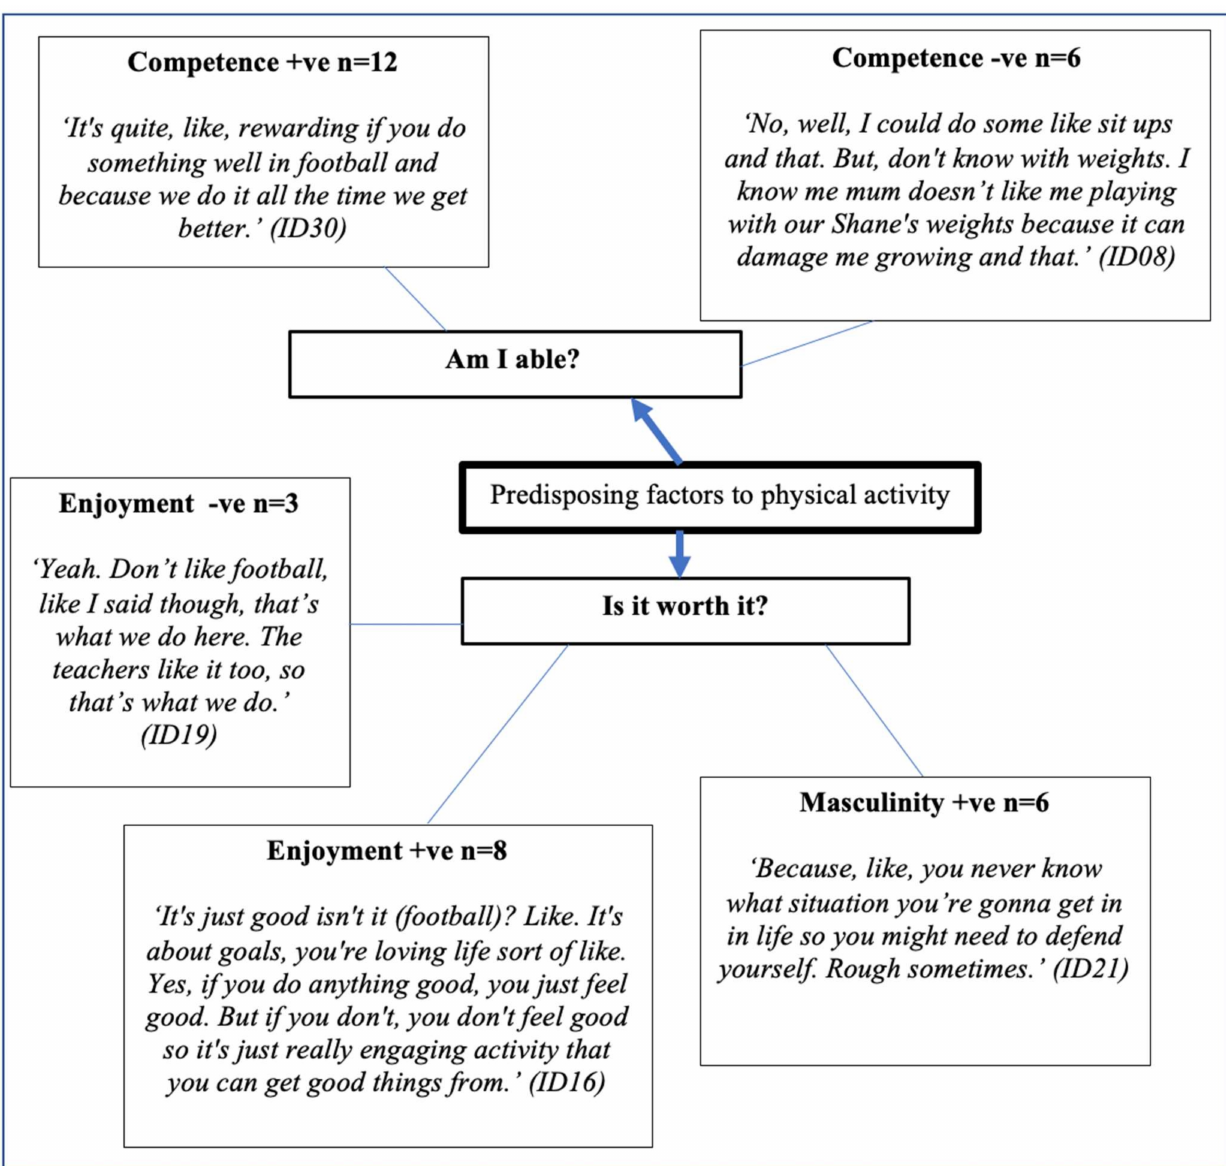
Figure 2. Predisposing factors to physical activity. +ve = positive; − ve =